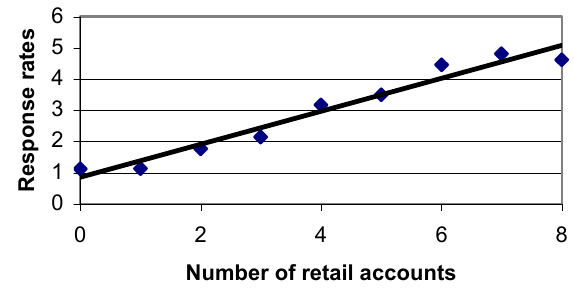
Figure 1: Scattergram of